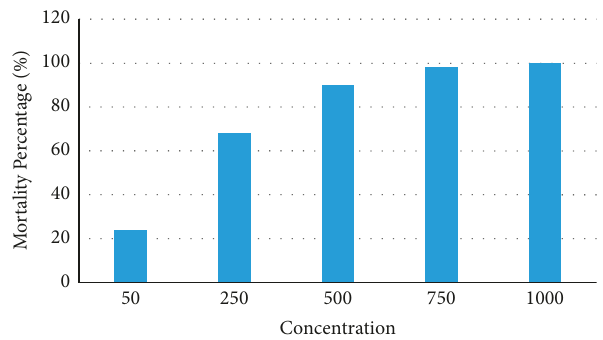
Figure 1: The toxicity test results of the concentration of clove flower extract ( Syzygium aromaticum ) on Artemia salina larvae.